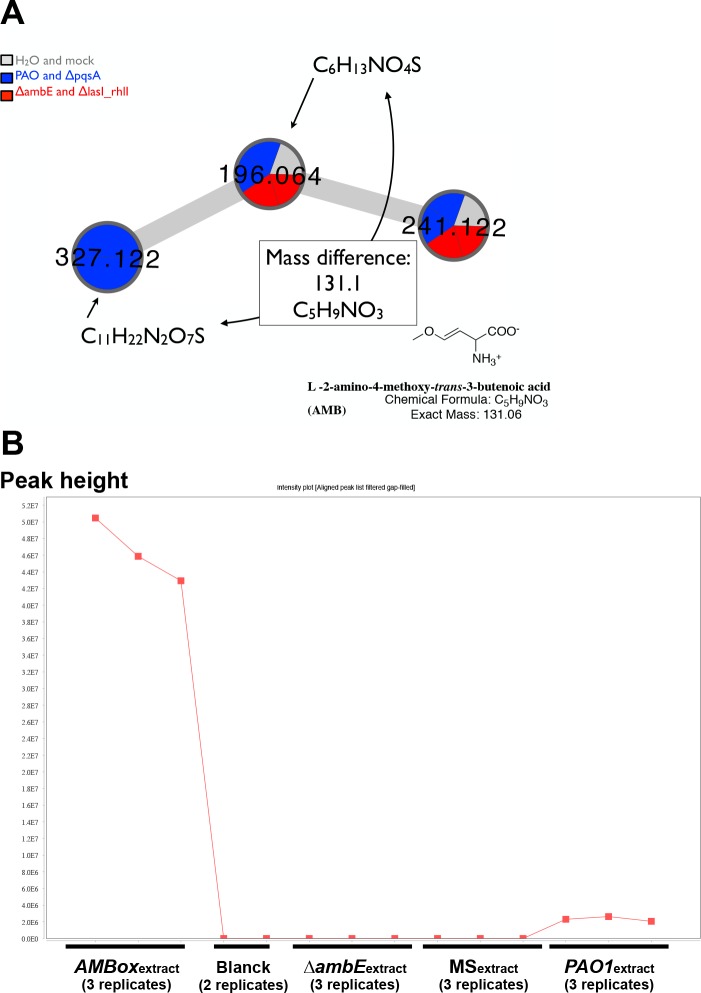
m/z 327.12 is the Mass Spectrometry (MS) signature of AMB.(A) Specific cluster of the molecular network realized on UHPLC-HRMS2 data acquired on extracts from strains releasing (PAO1 and ∆pqsA) or not releasing a GRA (∆ambE and ∆lasI∆rhlI). Color mapping grouped the MS/MS spectrum as following: blue if acquired from WT (PAO1) or ∆pqsA (∆pqsA) P. aeruginosa extracts, red if acquired from ∆ambE (∆ambE) or ∆lasI∆rhlI (∆lasI∆rhlI) mutant P. aeruginosa extracts and grey if acquired from analytical blanck (H2O) or culture media (MS) extracts. (B) Peak intensities visualization plot of the extracted ion trace from feature m/z 327.12 at 0.46 min. This plot shows the intensity of this particular feature across samples of AMBox [n = 3], analytical blanck [n = 2], ∆ambE [n = 3], culture media extract [n = 3] and PAO1 [n = 3], in this respective order.